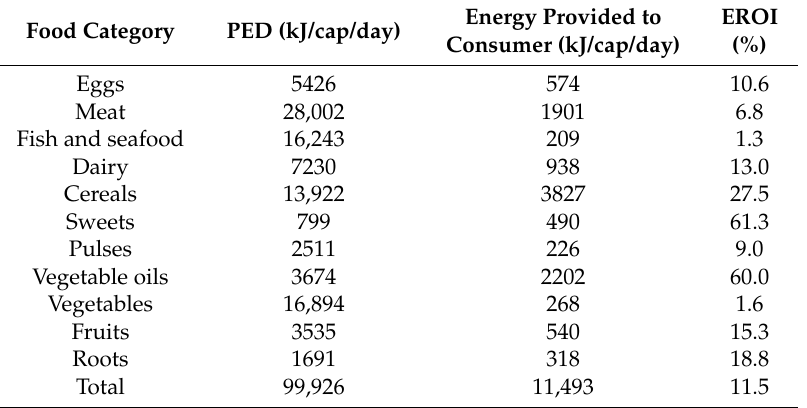
Table 1. Primary energy demand, nutritional energy provided to consumer and energy return on investment. Values expressed in kilojoules per capita per day and